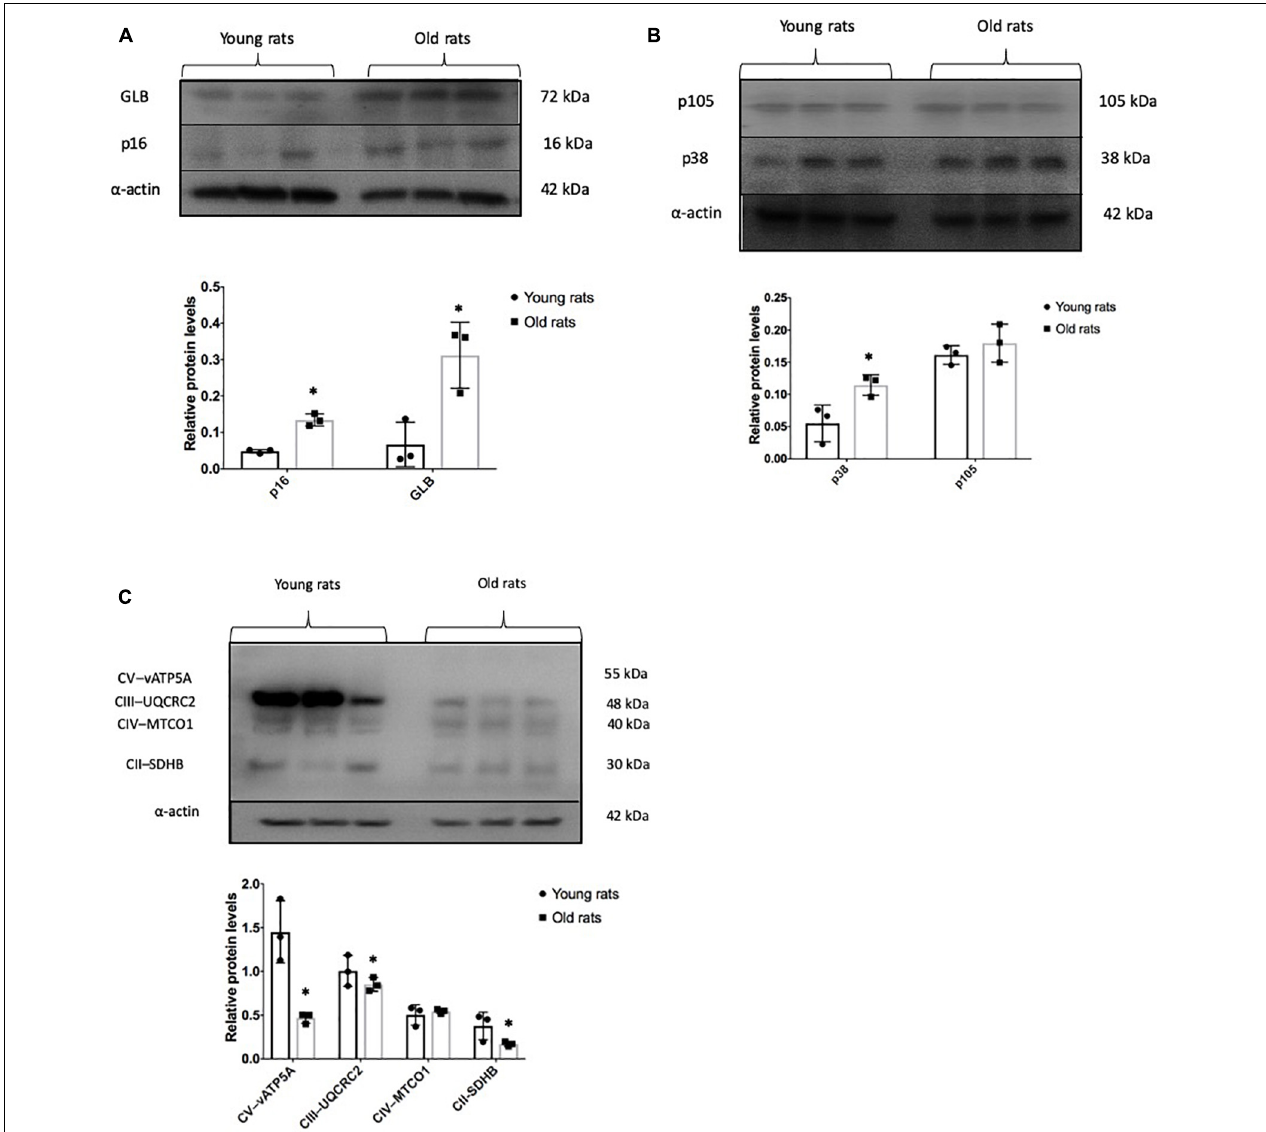
FIGURE 5 | Senescent and mitochondrial marks in the old and young cerebral cortex. Representative Western blots and densitometric analysis of proteins isolated from young (4 months old) and old (24 months old) rats as described in the methodology. (A) Senescent marks: p16 and GLB. (B) Proteins related to senescence-associated secretory phenotype (SASP) production. p38 and p105. (C) Representative proteins in mitochondrial OXPHOS. Each bar represents the mean ± SE of three independent experiments. Statistical significance with respect to young rats ∗ p ≤